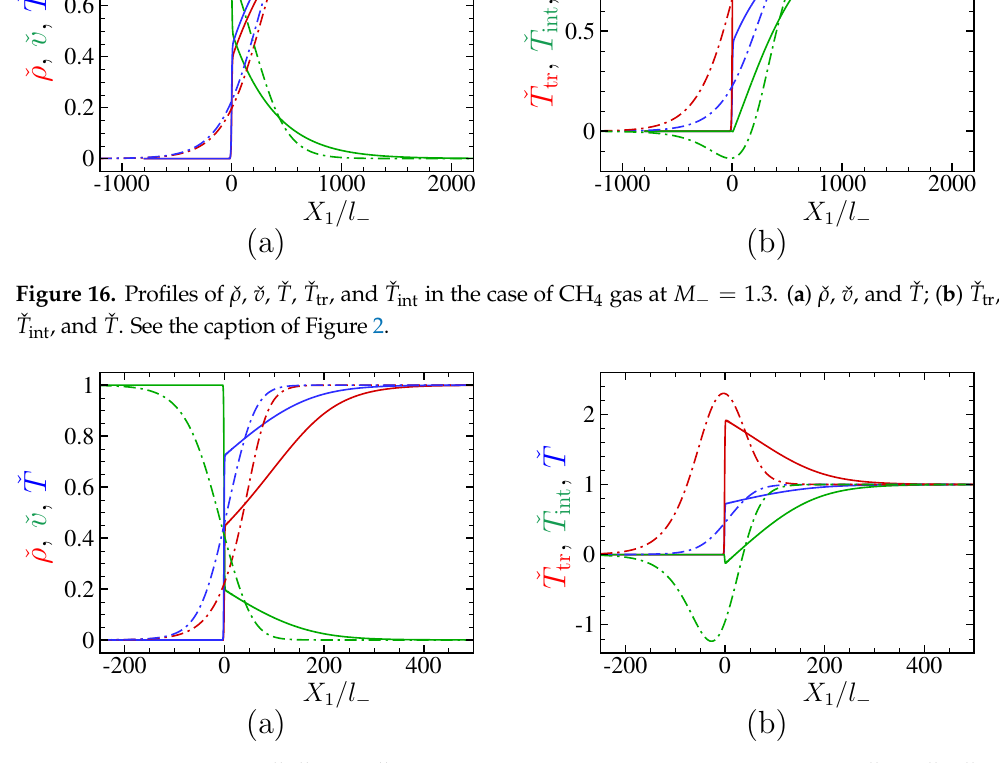
Figure 17. Profiles of ˇ ρ , ˇ v , ˇ T , ˇ T tr , and ˇ T int in the case of CH 4 gas at M − = 3. ( a ) ˇ ρ , ˇ v , and ˇ T ; ( b ) ˇ T tr , ˇ T int , and ˇ T . See the caption of Figure